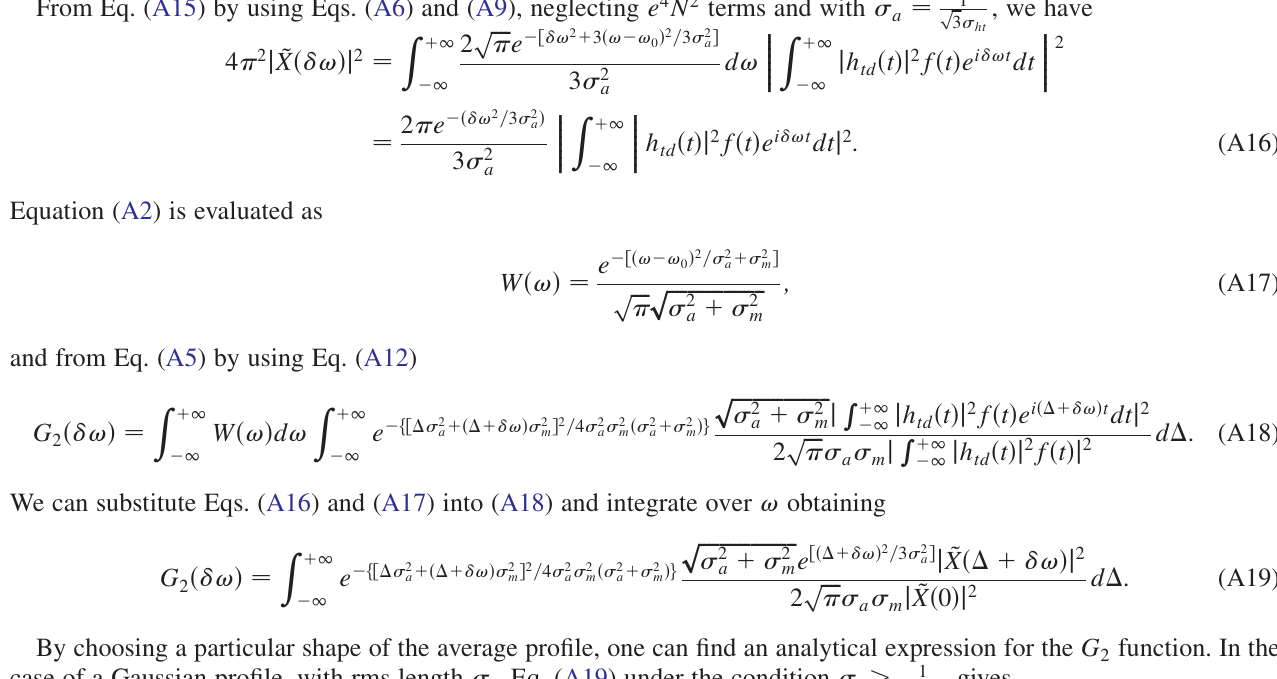
ffiffiffiffiffiffiffiffiffiffiffiffiffiffiffiffiffiffiffi